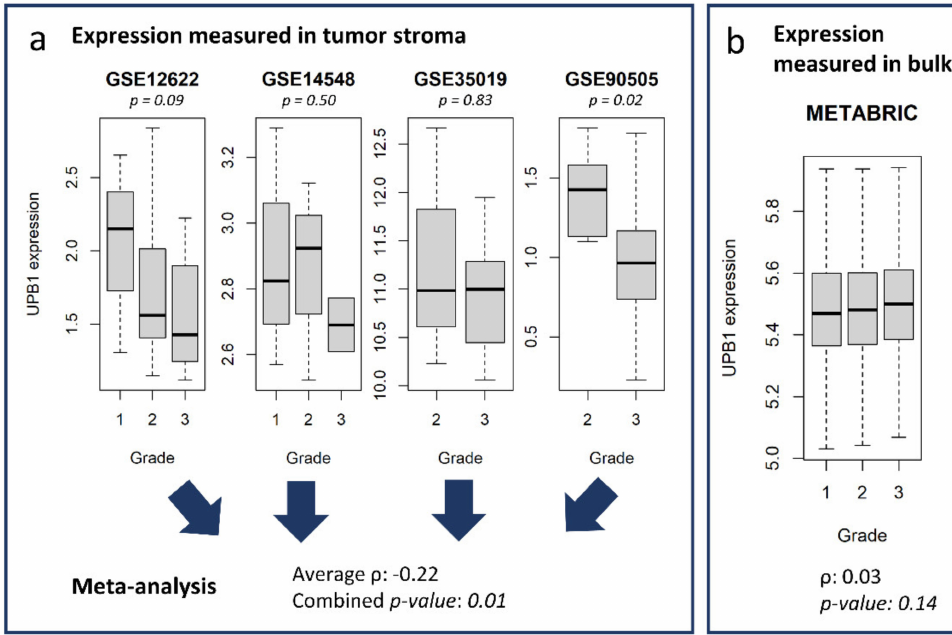
Figure 6. UPB1 is correlated with lower grade in the stroma, but not in bulk. ( a ) UPB1 expression in the 4 datasets with annotation for grade in the tumor stroma. The p -value for the correlation between UPB1 expression and tumor grade is indicated above each boxplot. Collapsing p -values with a meta-analysis, the statistical power increases, and the p -value reaches significance. Overall, the correlation between UPB1 expression and tumor grade in stroma is significantly negative. ( b ) no significant relationship between UPB1 expression and tumor grade in bulk in the METABRIC